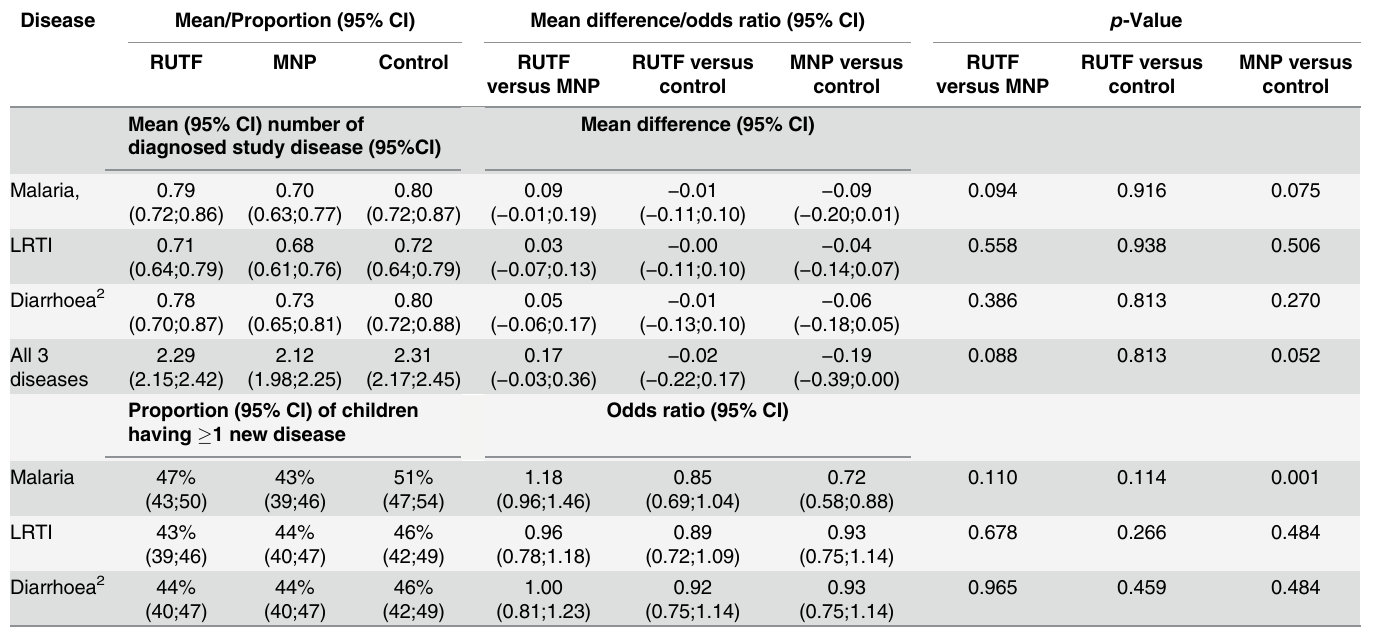
Table 6. Mean number of diagnosed events and proportion of children with at least one newly diagnosed study disease episode 1 . Disease